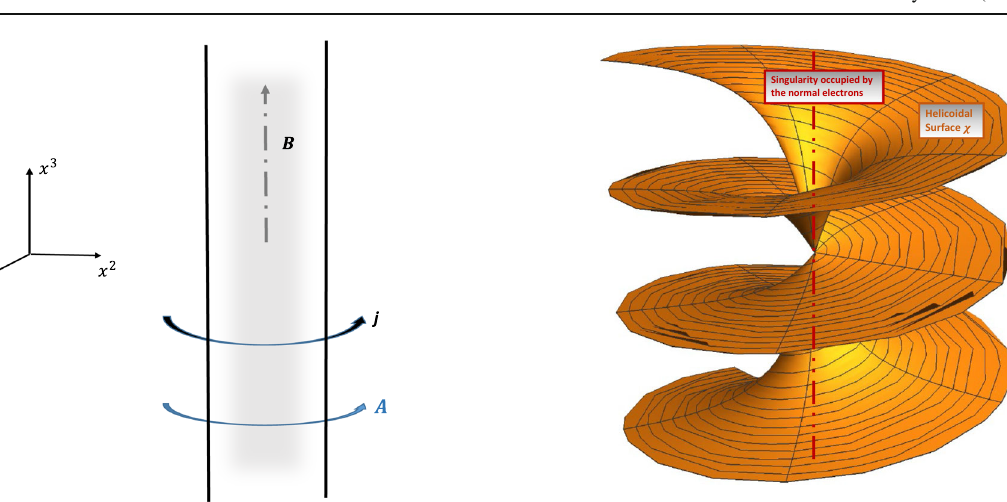
Fig. 1 The magnetic flux penetrates a type II superconductor in the formofvortexlineswhen B exceedsacriticalfield.Intheplotisreported the vector potential A , the supercurrent j = ( j 1 , j 2 , 0 ) , Eqs. (27) and (28), and the magnetic field B = ( 0 , 0 , B 3 ) in a vortex line, Eq. (26)